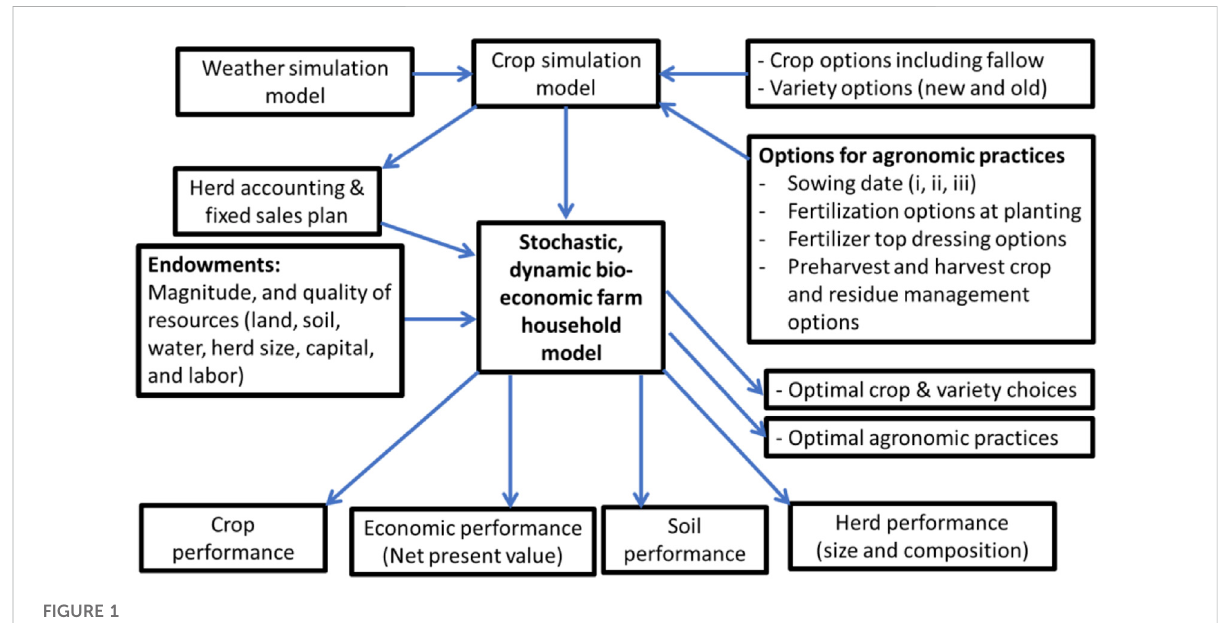
FIGURE 1 The modelling framework used in this